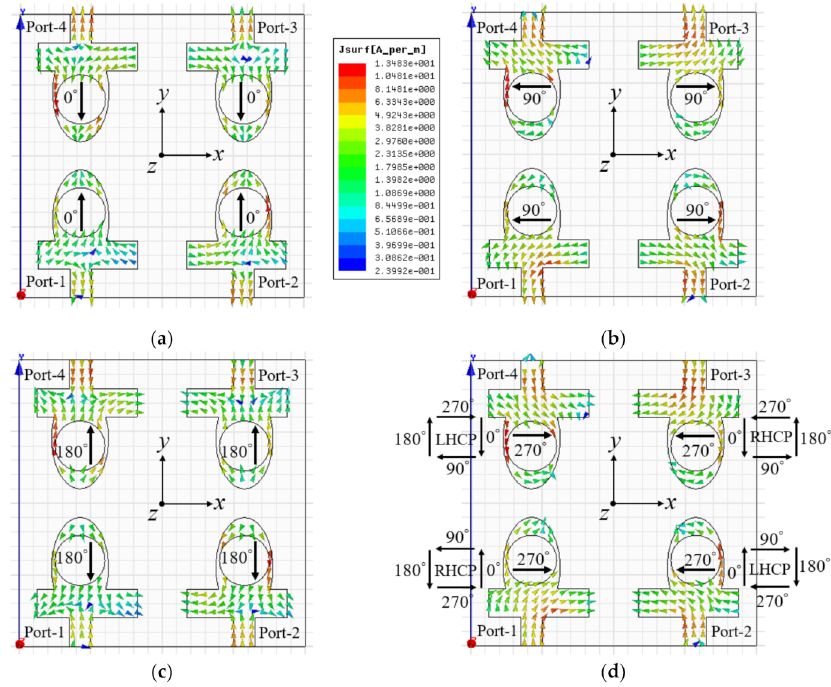
Figure 7. Surface current distribution at 3.6 GHz ( a ) ω t = 0 ◦ ; ( b ) ω t = 90 ◦ ; ( c ) ω t = 180 ◦ ; and ( d ) ω t = 270 ◦